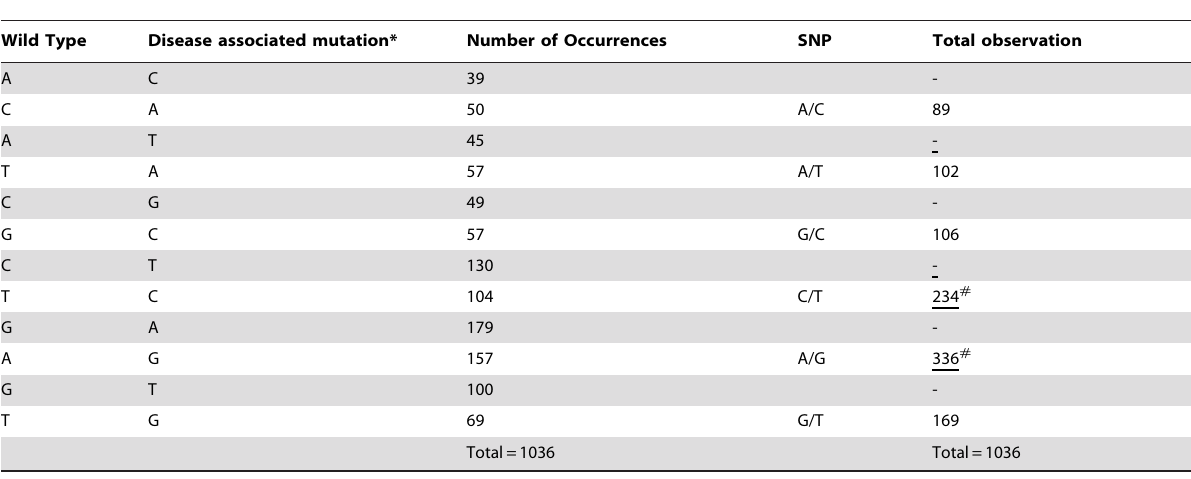
Table 2. Transition Bias in CFTR Mutations Associated with Human